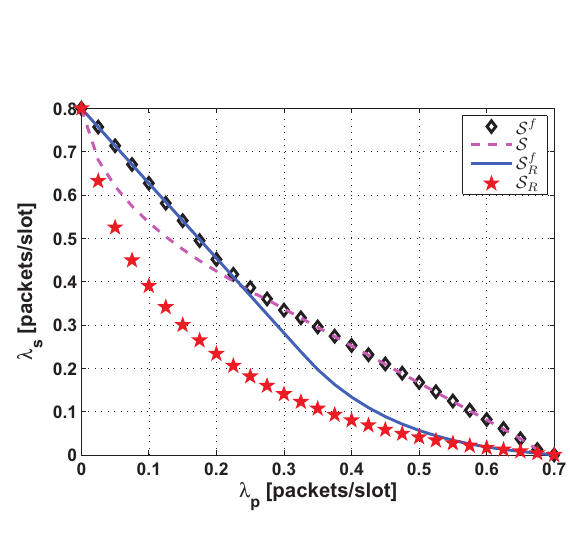
Figure 4. Stability region of the proposed systems.